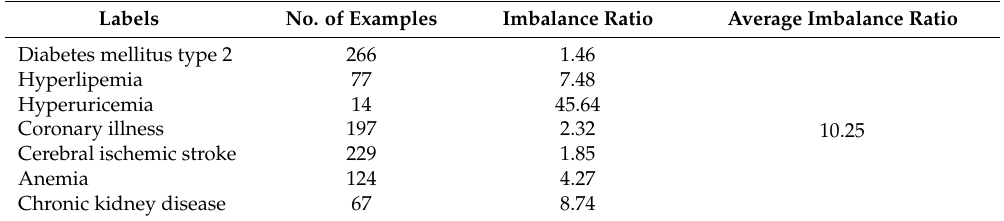
Table 3. The Statistics of